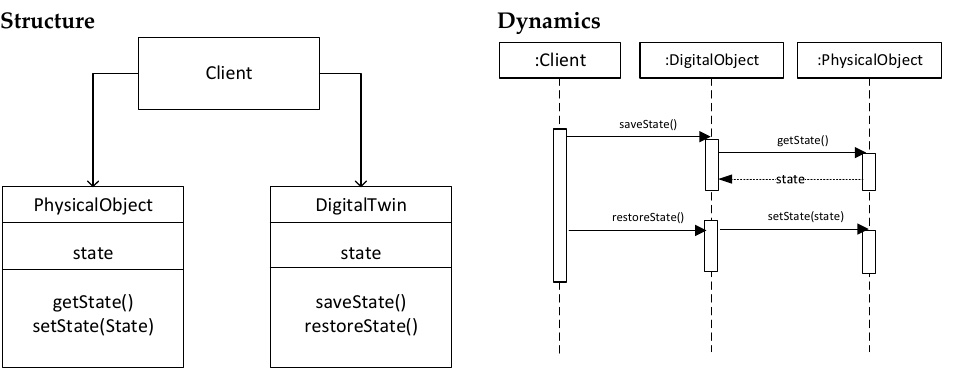
Figure 12. Digital Restoration